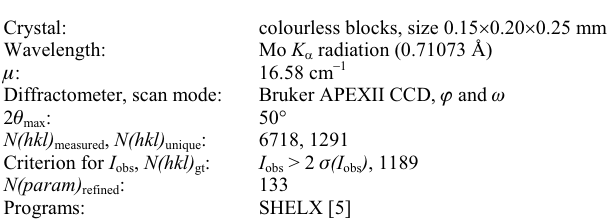
Table 1. Data collection and handling.